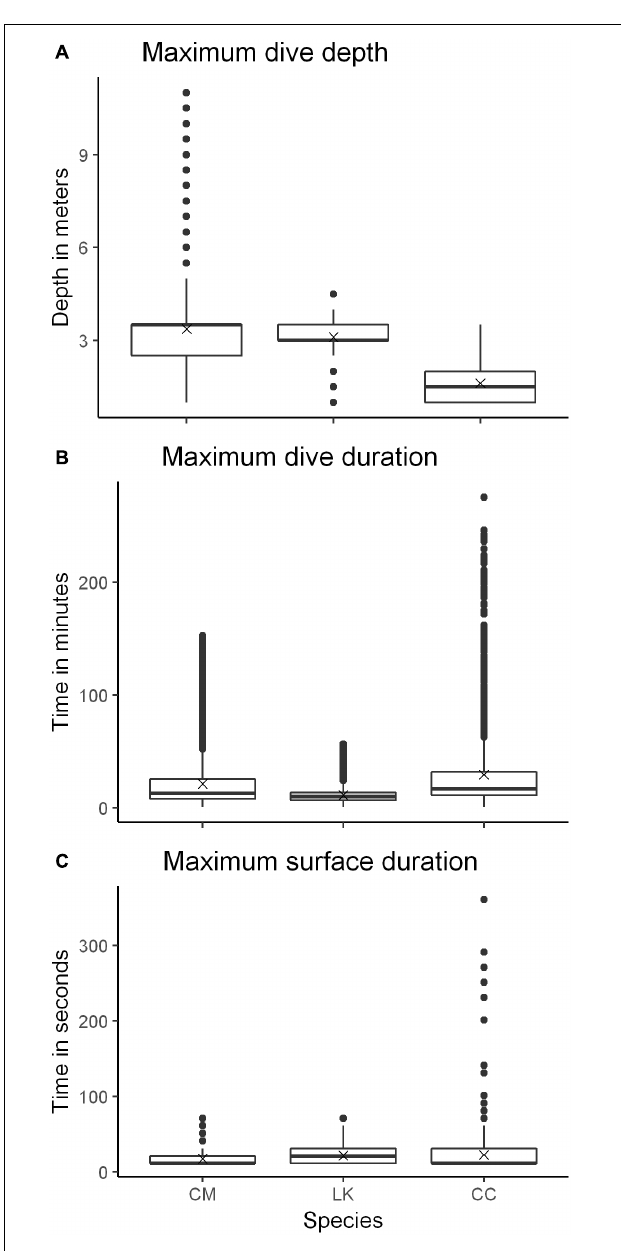
FIGURE 7 | Box-plots of three diving behavior parameters: (A) maximum dive depth, (B) maximum dive duration, and (C) maximum surface duration, for each species. Data were obtained from 13 turtles (7 CM green turtles; 4 LK Kemp’s ridley turtles; and 2 CC loggerhead turtles), tracked between July and September (2014–2017) in the Crystal River region, United States. Box-plot description: whiskers represent the minimum and maximum values, box represents values in the second and third quantiles, line inside the box represents the median, “x” represents the mean, circles represent outliers.